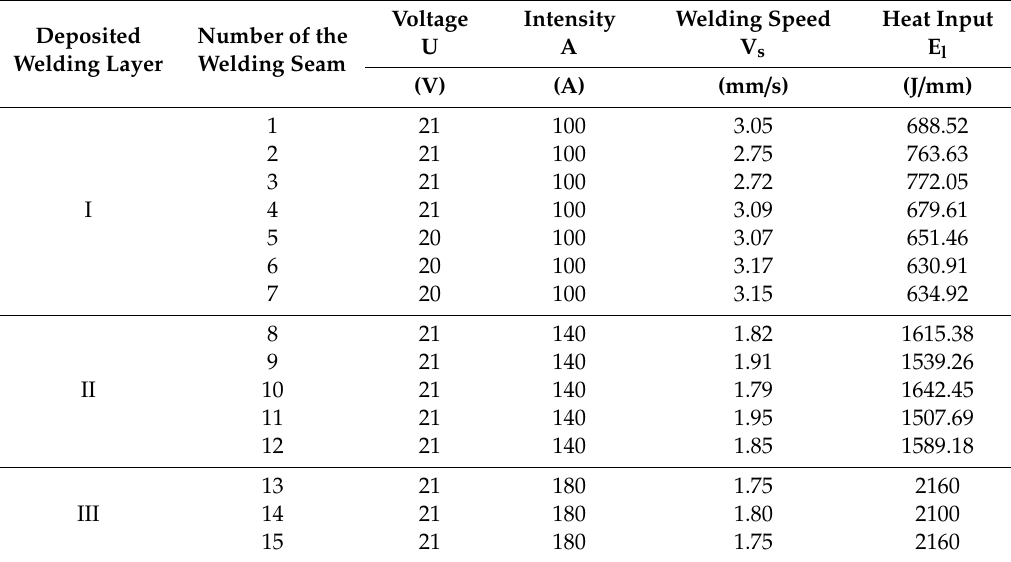
Table 5. Welding regime of sample I at the deposition of the first